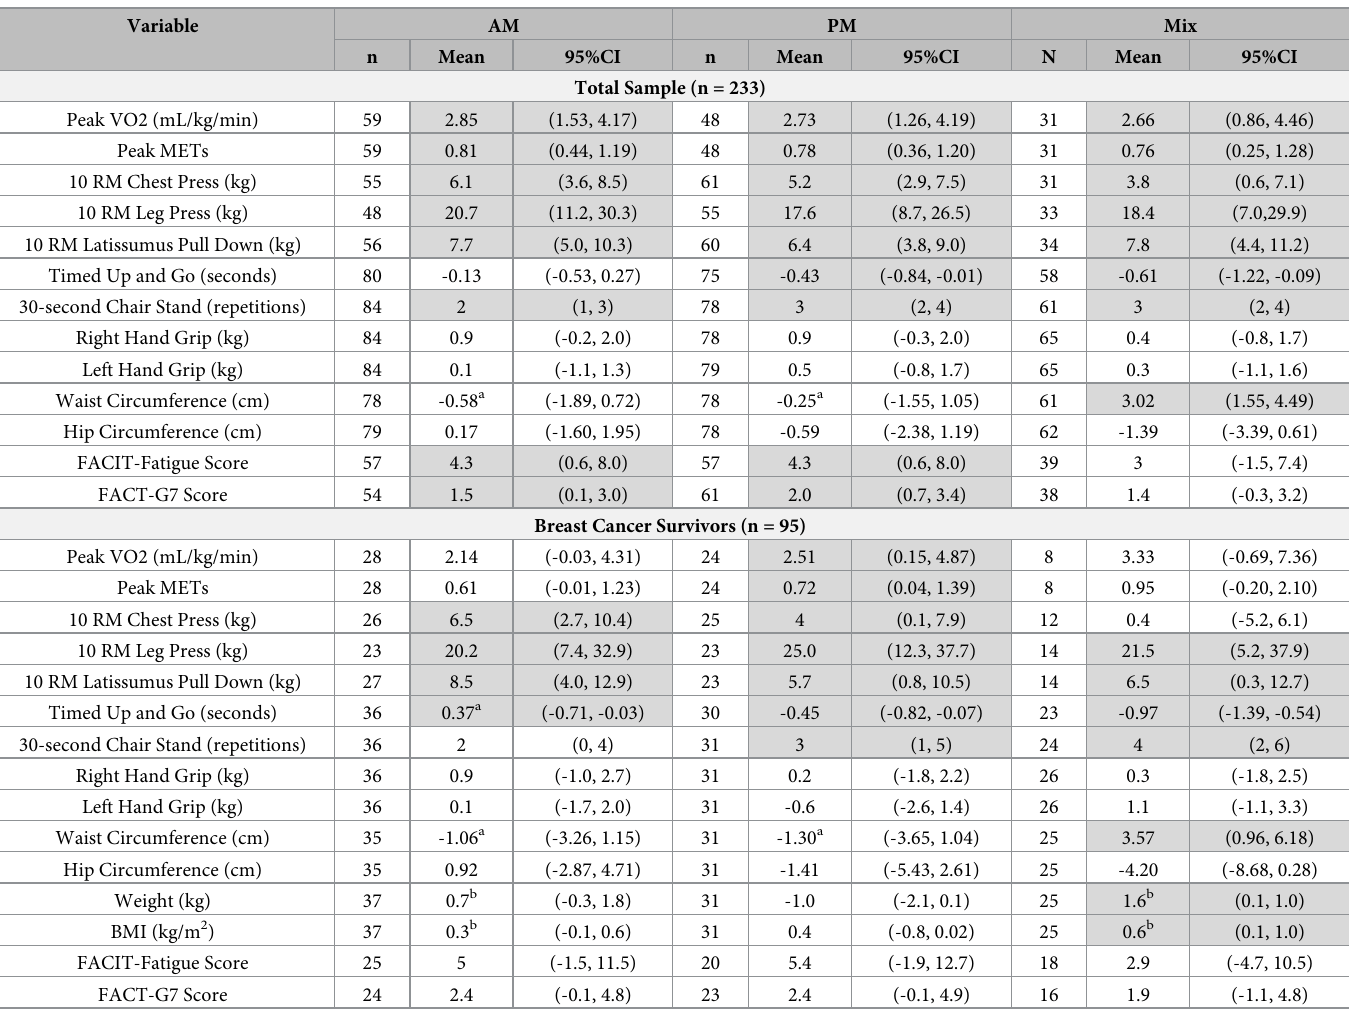
Table 1. Mean change in health outcomes by time-of-day of habitual exercise